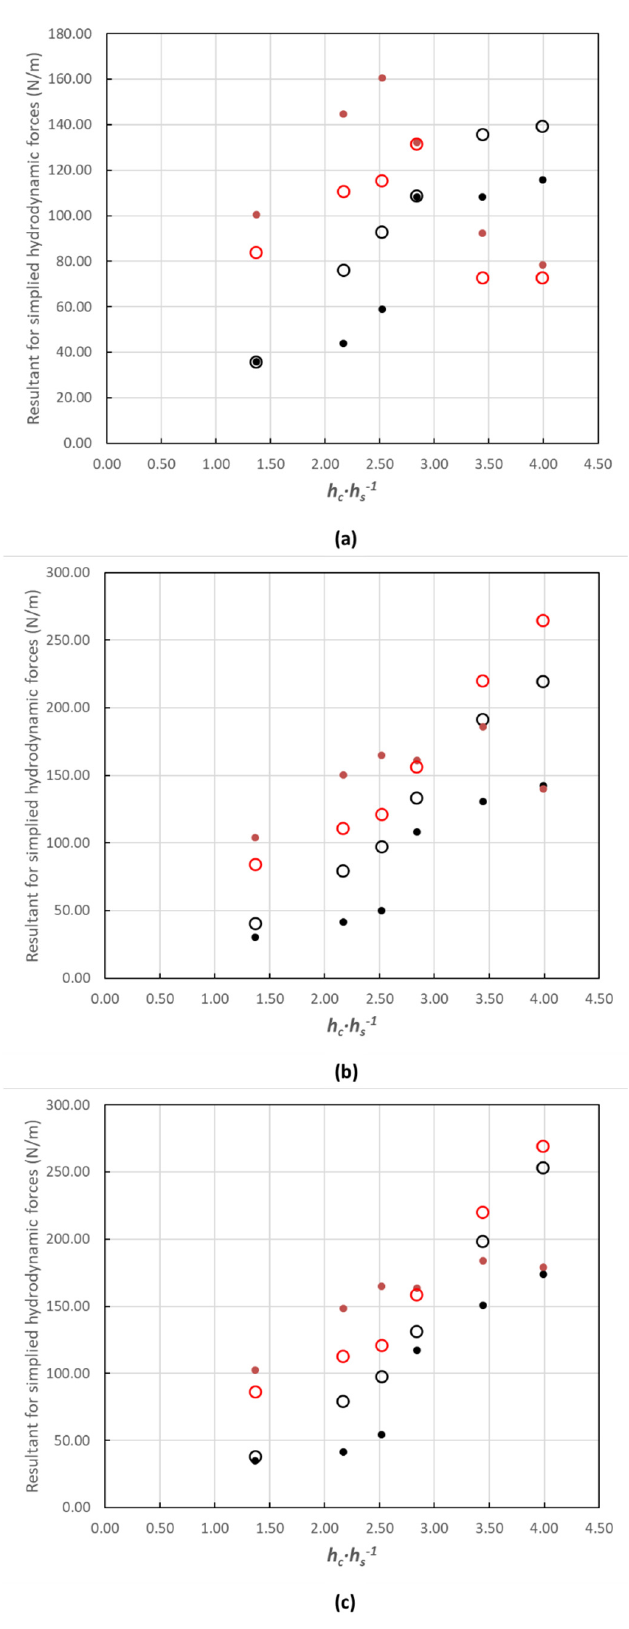
Figure 23. Resultant of the hydrodynamic forces on the block tread and base for the Armorwedge TM ( w 1) and ACUÑA ( w 2) block for unit flow rates ( q ) from 0.04 ( h c h s − 1 = 1.37) to 0.24 m 2 s − 1 ( h c h s − 1 = 3.99): ( a ) joints unsealed; ( b ) longitudinal joints sealed; ( c ) longitudinal and transversal joints sealed.